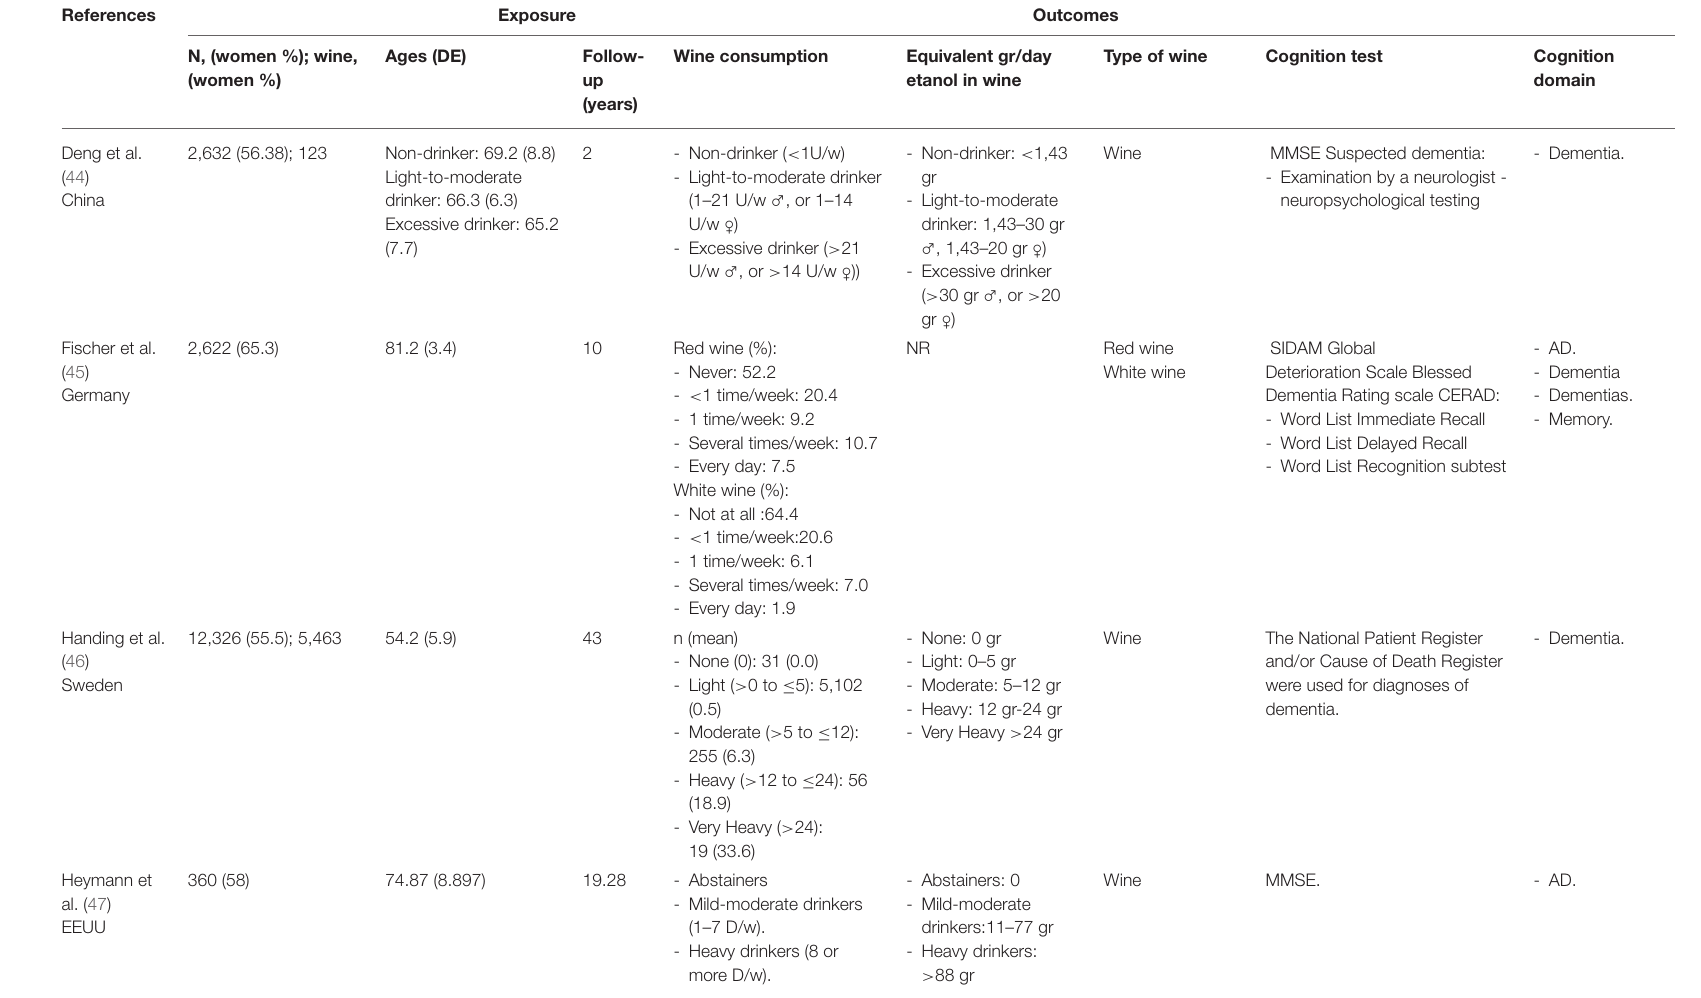
TABLE 1 | Main characteristics of the included